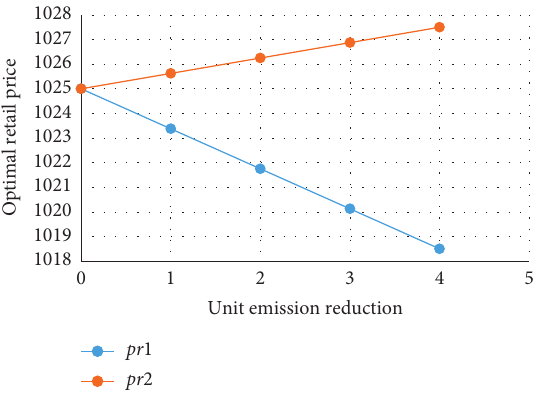
Figure 5: Retailer price comparison chart.